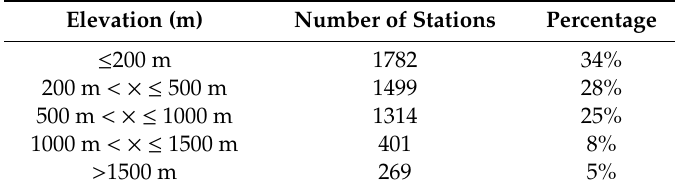
Table 2. Distribution of the rain gauges included in I 2 -RED over di ff erent elevations.